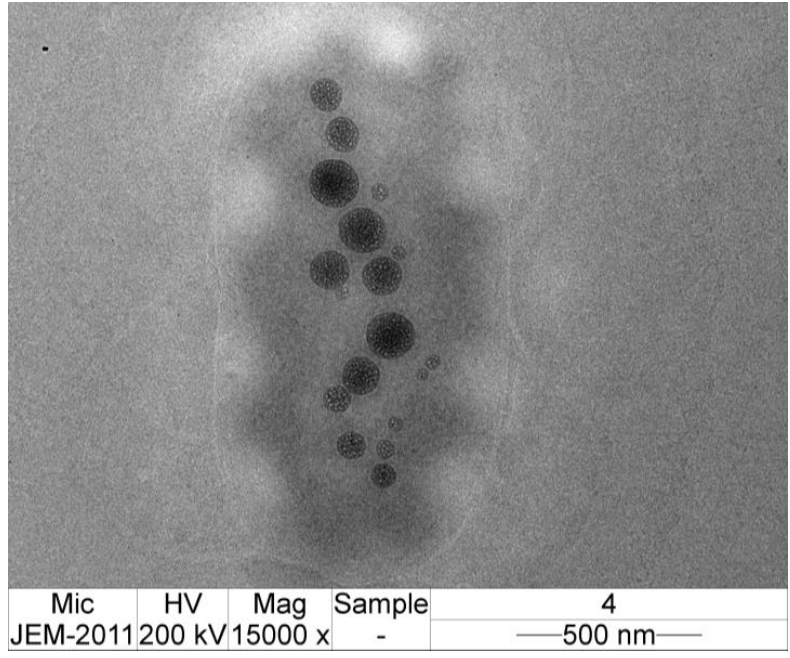
Figure 5. TEM imaging of CMCS-Ca 2+ nanoparticles obtained from the ultrasound-assisted technique at 75% of amplitude and 180 s of time.